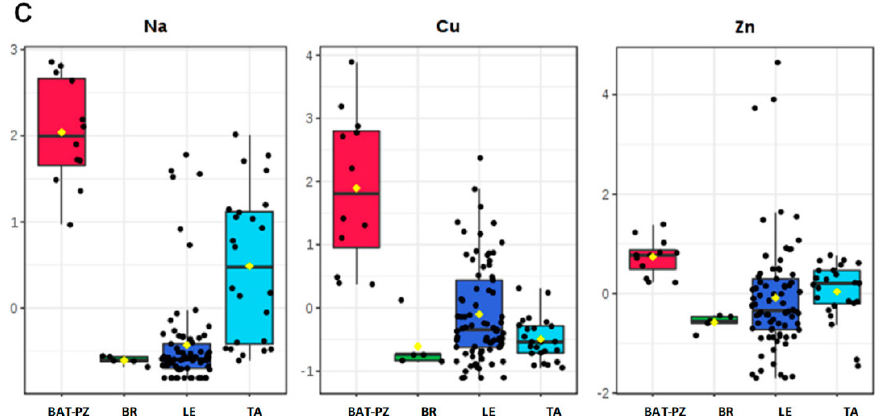
Figure 4. Box plot for the discriminant microelements sodium (Na), copper (Cu), and zinc (Zn) as obtained for olive leaf samples obtained from olive groves of the non-infected area BAT - PZ (BAT: Barletta—Andria—Trani and PZ: Potenza provinces) and from olive groves of the infected areas: BR (province of Brindisi), LE (province of Lecce), and TA (province of Taranto). C: panel C from the figure reproduced from [82].